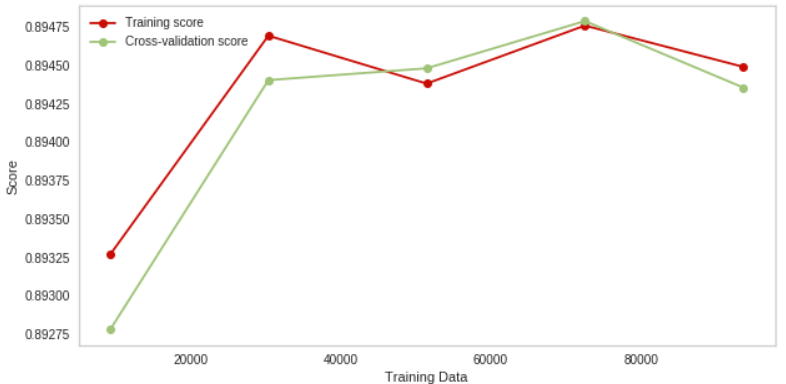
Figure 23. Binary class logistic regression training and validation learning curve.